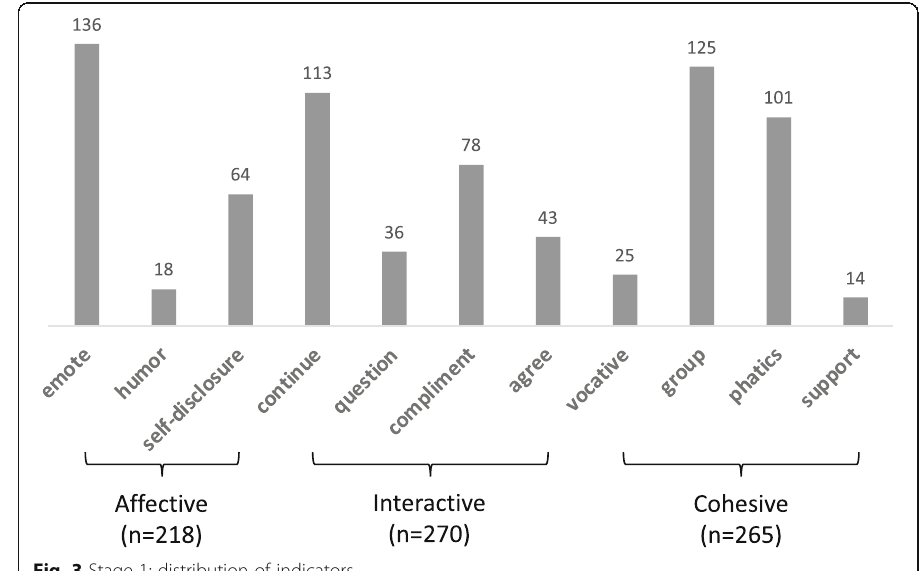
Fig. 3 Stage 1: distribution of